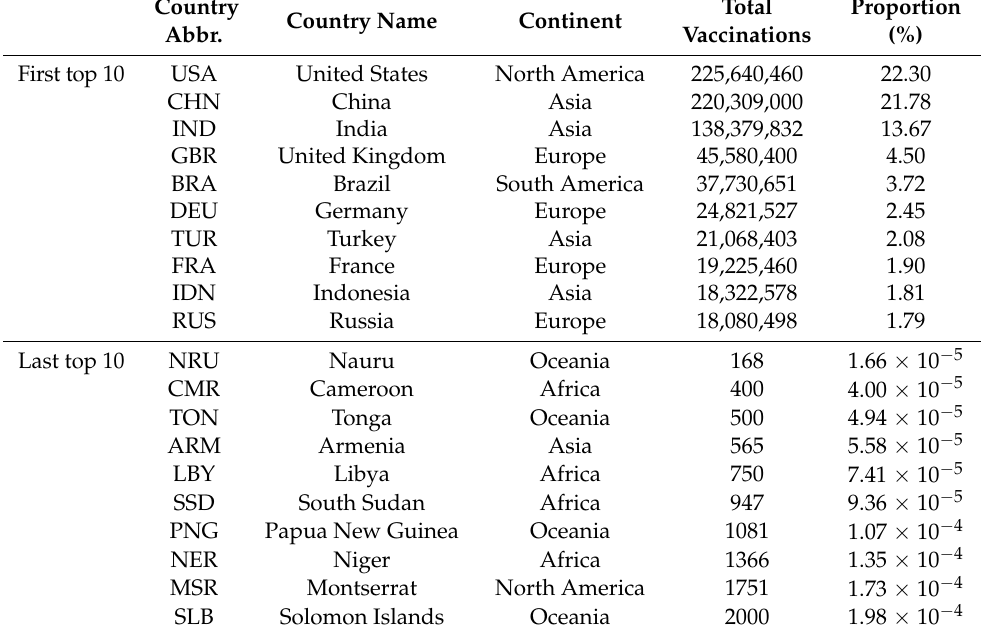
Table 1. The first and last top 10 countries of percentage of vaccine doses worldwide. Country